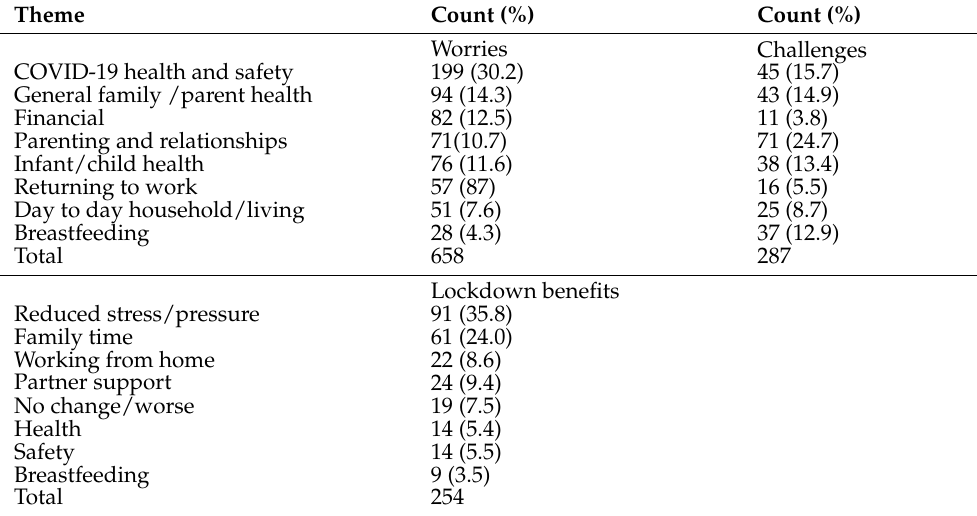
Table 5. Worries, challenges, and lockdown benefits cited by